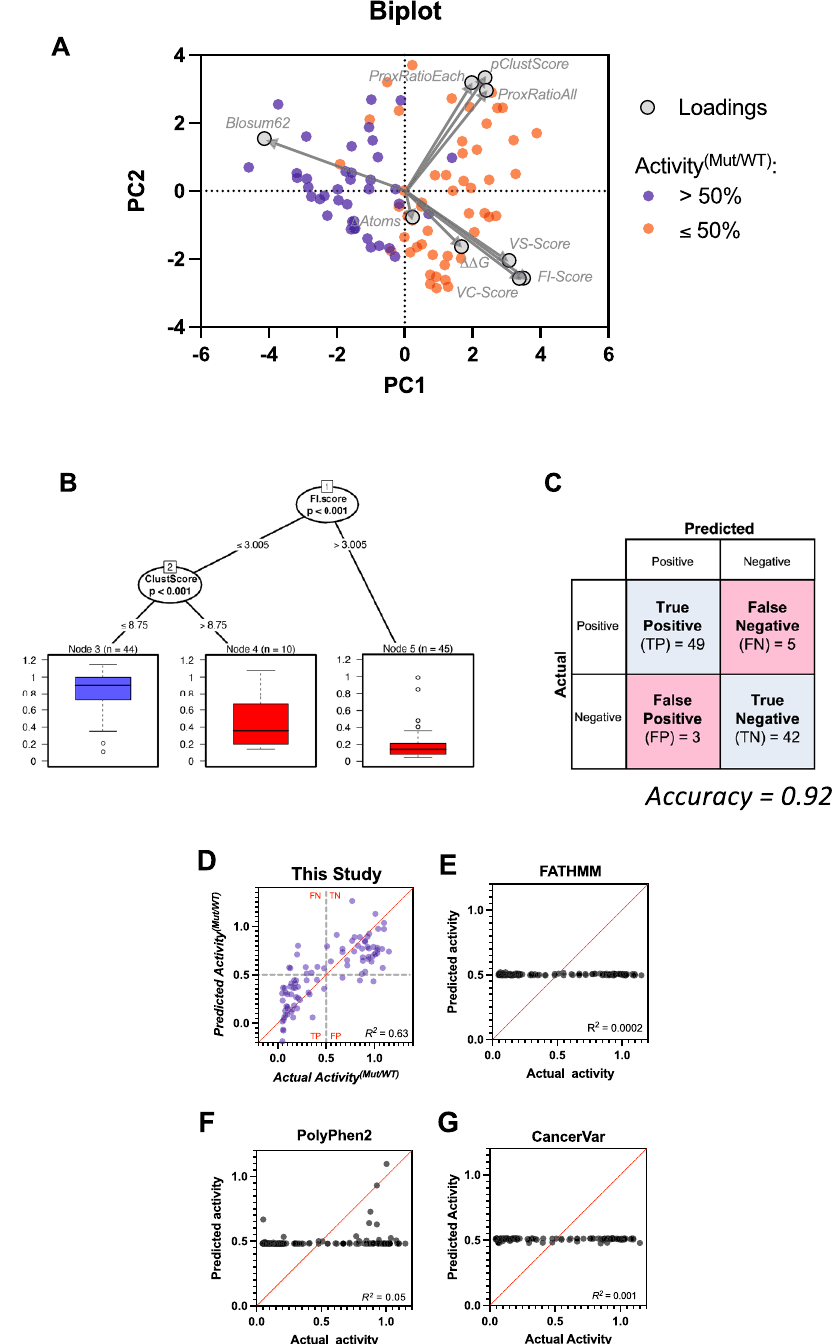
Figure 5. Phylogenetic and clustering parameters predict functional impact of cancer-associated missense variants of uncertain significance (VUS). ( A ) Principal component (PC) biplot of significant phylogenetic ( FI-Score, VC-Score and VS-Score ), clustering ( pClustScore, ProxRatioAll, ProxRatioEach ) and physical–chemical ( ΔAtoms, Blosum62, ΔΔG ) parameters. Red, VUS with enzymatic activity ≤ 50% of wild-type (WT); blue, VUS with activity > 50% of WT. Mut, mutant. ( B ) Recursive partitioning classification tree for enzymatic activity using FI-score , pClustScore , ΔAtoms, Blosum62 and ΔΔG parameters for MLL1-3 VUS. Circles, internal nodes that can be partitioned into subnodes; boxes, terminal nodes; red, VUS with activity ≤ 50% of WT; blue, VUS with activity > 50% of WT. Circles, P values input nodes; box plots of Activity (MT/WT) values are in terminal nodes. (Goodness of Fit R 2 = 0.65, RMSE = 0.22) ( C ) Confusion matrix showing predictive accuracy of the tree based on the tenfold cross-validation scheme. The recursive partitioning algorithm was repeated 85 with 10 rounds of fitting, each using randomly chosen data subsets, with 90% training set and 10% testing set. D-G ) Actual vs. Predicted plots. X-axes, actual activity; y-axes, predicted activity based on the regression model. Red diagonal line, line of identity; dashed lines, cutoff for VUS with less than or greater than 50% WT activity. ( D ) FI-Score and pClustScore parameters as predictors. ( E ) FATHMM inference score as predictor. ( F ) PolyPhen-2 inference score as predictor. ( G ) CancerVar Oncogenic Prioritization by Artificial Intelligence (OPAI) score as predictor. Shown are adjusted R 2